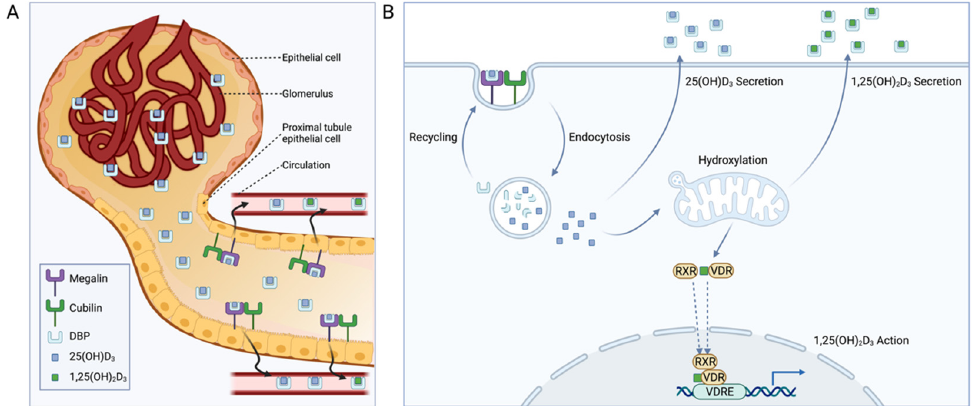
Figure 3. Role of megalin and cubilin in renal vitamin D homeostasis. ( A ) Proximal tubular epithelial cells take up vitamin D-binding protein (DBP)-bound vitamin D metabolites from the glomerular ultrafiltrate through a megalin and cubilin-mediated mechanism [75]. ( B ) After endocytosis within megalin-expressing cells, DBP is degraded and recycled, and 25-hydroxyvitamin D 3 (25(OH)D 3 ) can undergo 1 α -hydroxylation to the active 1,25(OH) 2 D 3 for subsequent vitamin D receptor (VDR) agonism through interactions with the retinoid X receptor (RXR) and VDR response elements (VDREs). Alternatively, endocytosed 25(OH)D 3 or synthesized 1,25(OH) 2 D 3 can be secreted to maintain circulating vitamin D homeostasis.